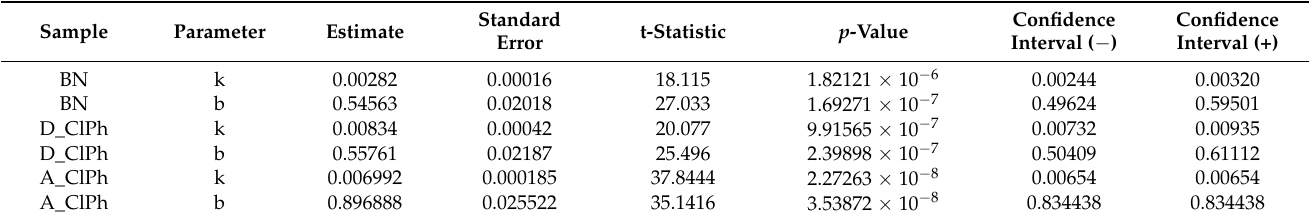
Table 7. Values of the estimated matching parameters for profiles along with statistics, significance level, and confidence interval.